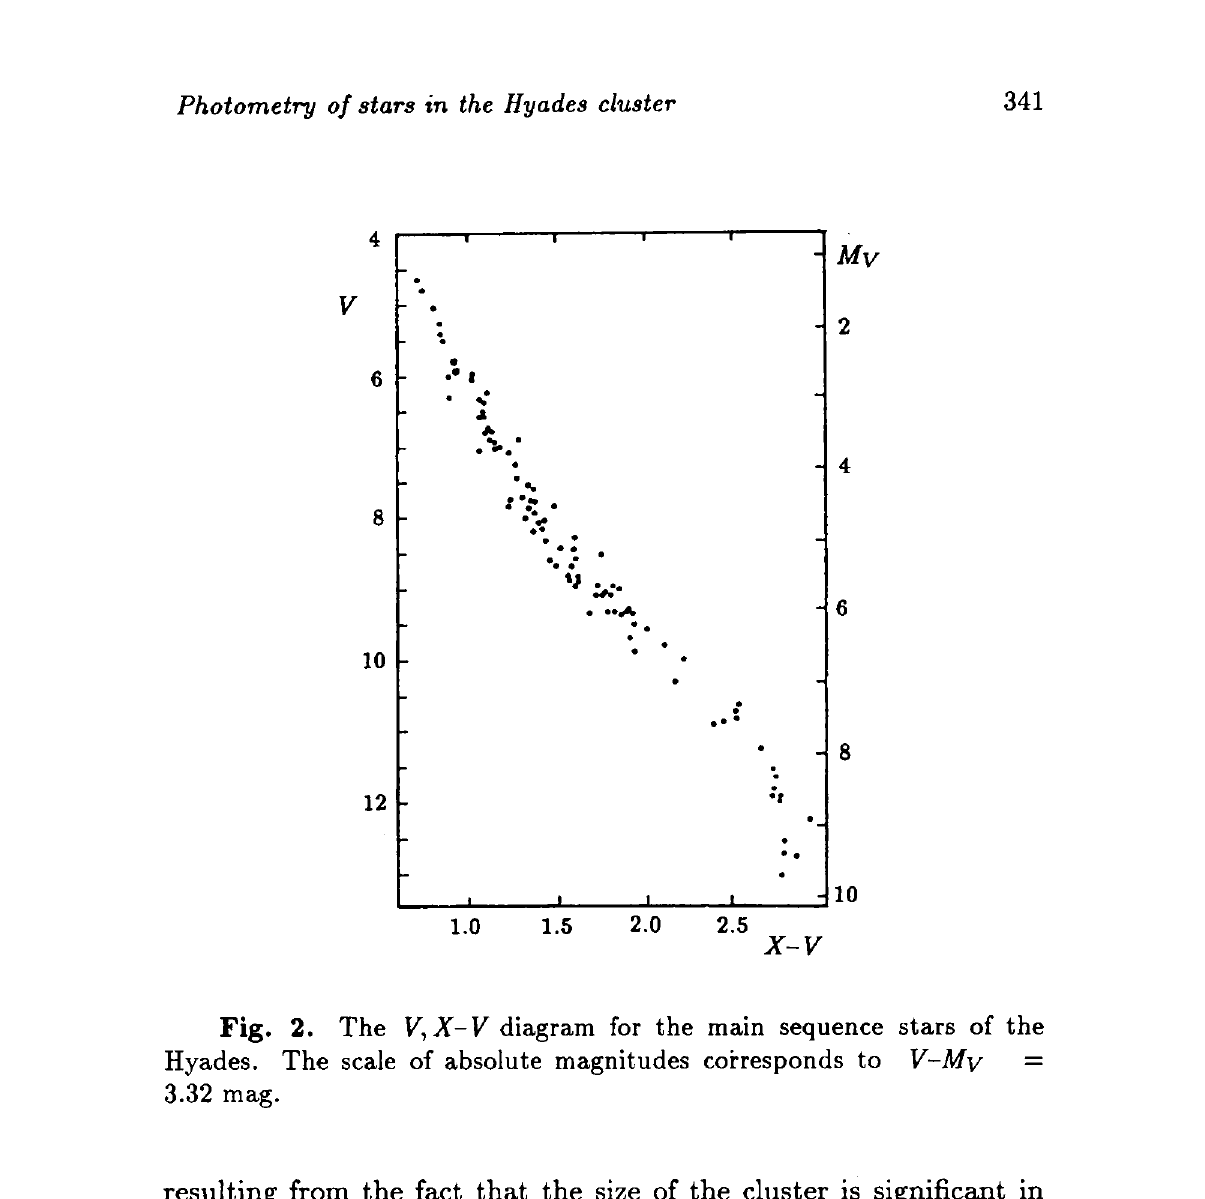
Fig. 2. The V, Χ- V diagram for the main sequence stars of the Hyades. The scale of absolute magnitudes corresponds to V-My = 3.32